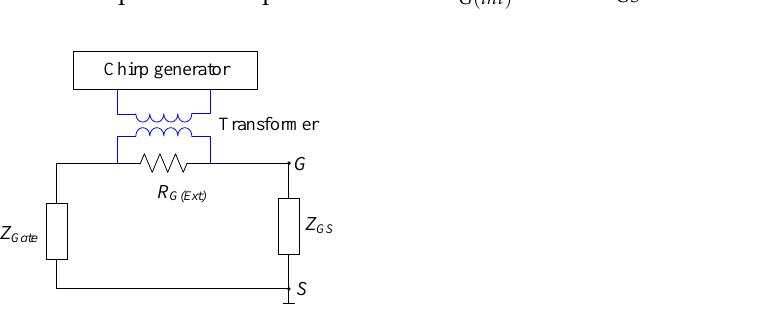
Figure 8. Principal schematic of applying a chirp signal into a gate driver.